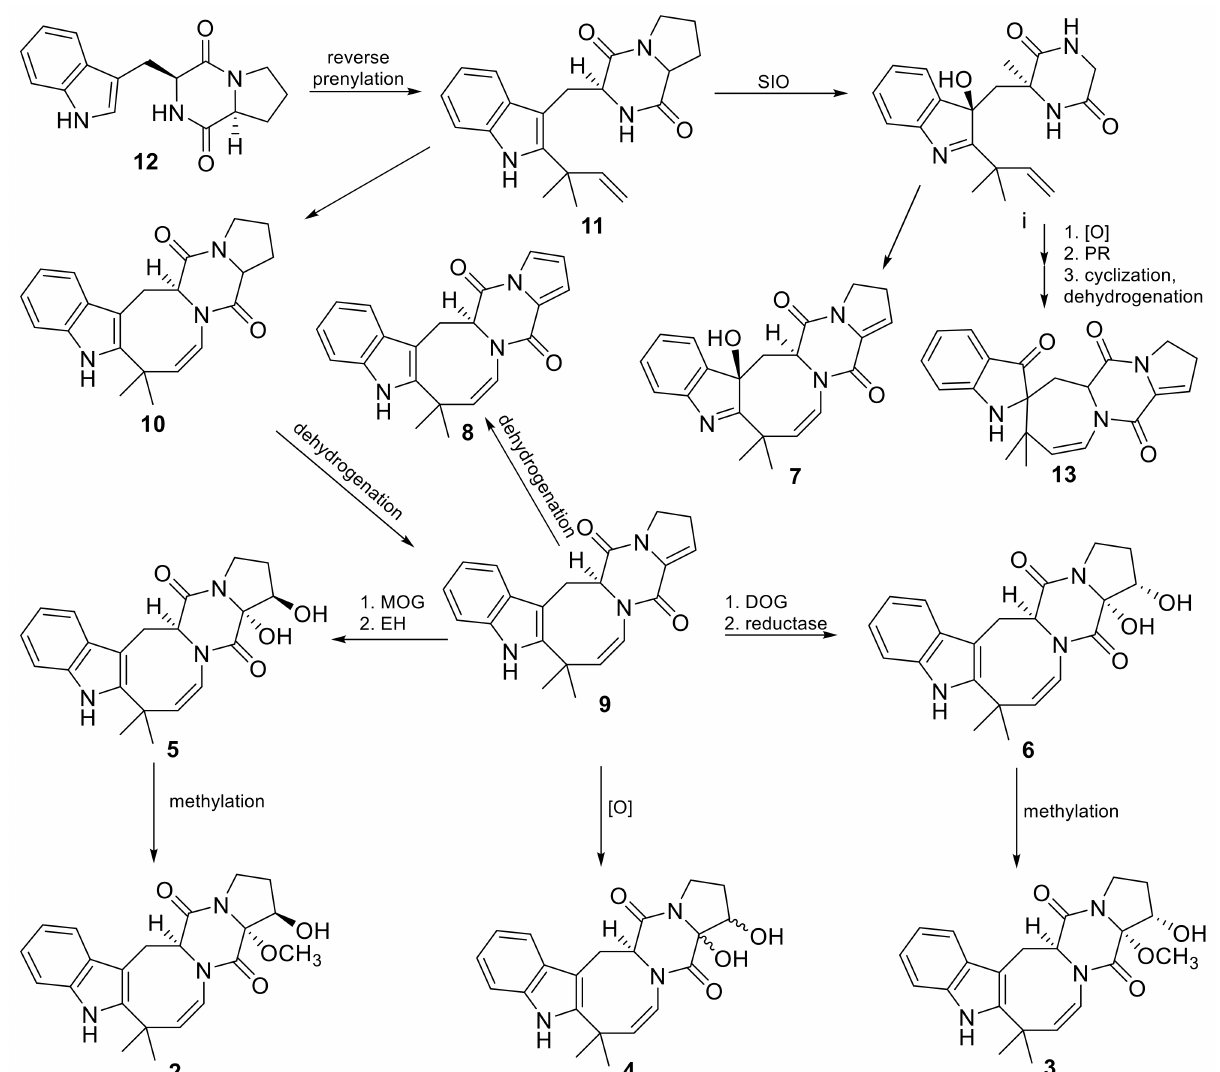
Figure 9. Plausible biosynthetic pathway for alkaloids 1 – 13 in Penicillium hispanicum . SIO—R- selective indoloxidase, PR—pinacol rearrangement, DOG—dioxygenase, MOG—monooxygenase, EH—epoxide